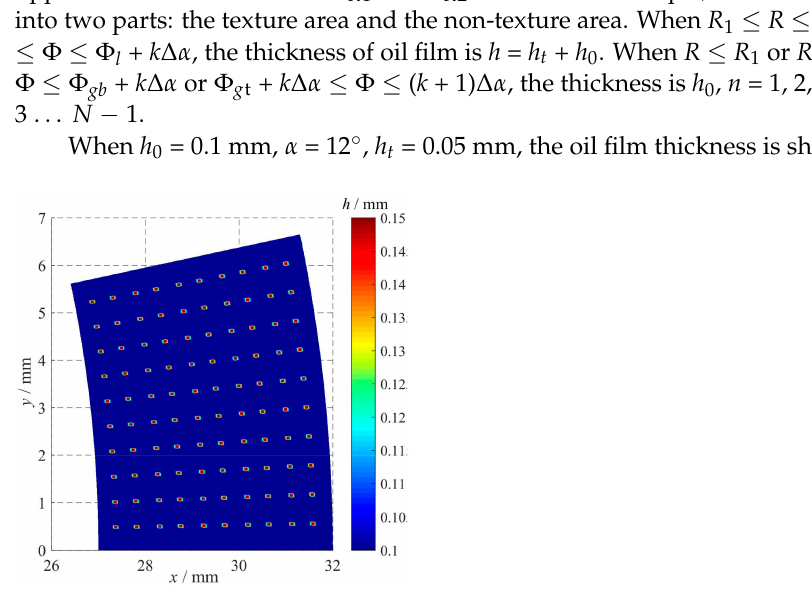
Figure 4. Film thickness under uniformly distributed hexahedron texture.